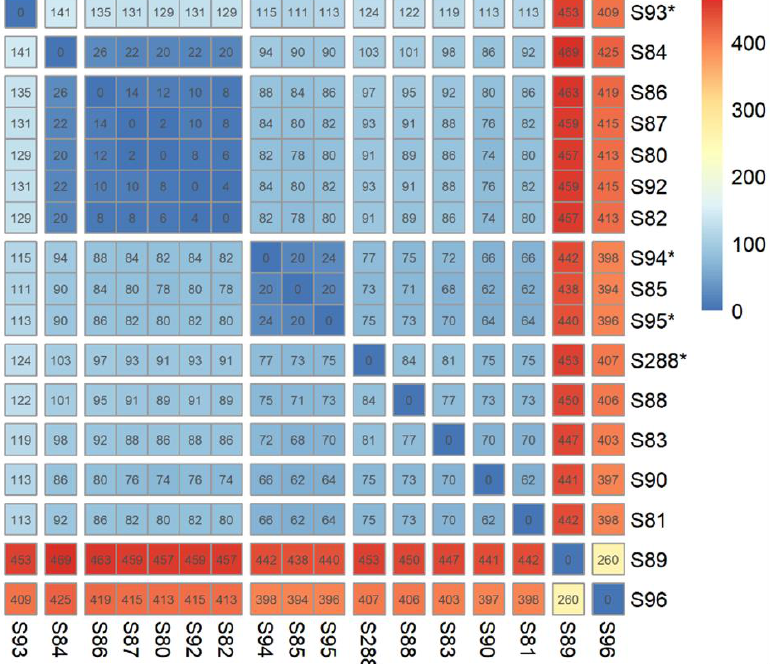
Figure 2. Distance matrix (SNP) of strains from our local collection ( n = 17). Isolates identified with «*» symbol had no bla ESBL gene. Five of our isolates were less than 15 SNP (S86, S87, S80, S92 and S82) or 26 (S84) from the nearest isolate. Table 1. Origin and sublineage distribution of E. coli ST141 isolates ( n = 128).